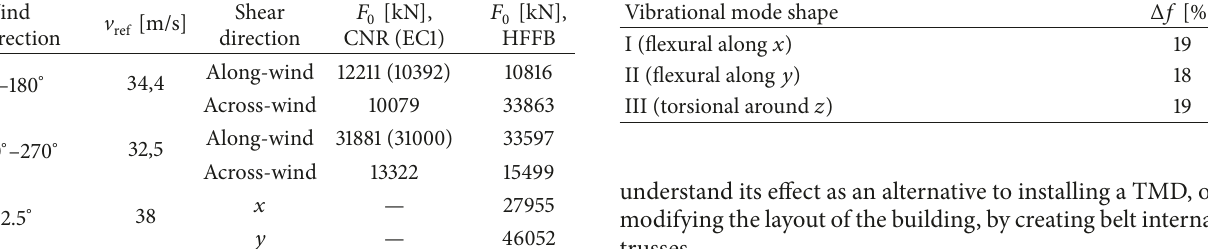
Table 6: Percentages of increase in the dominant